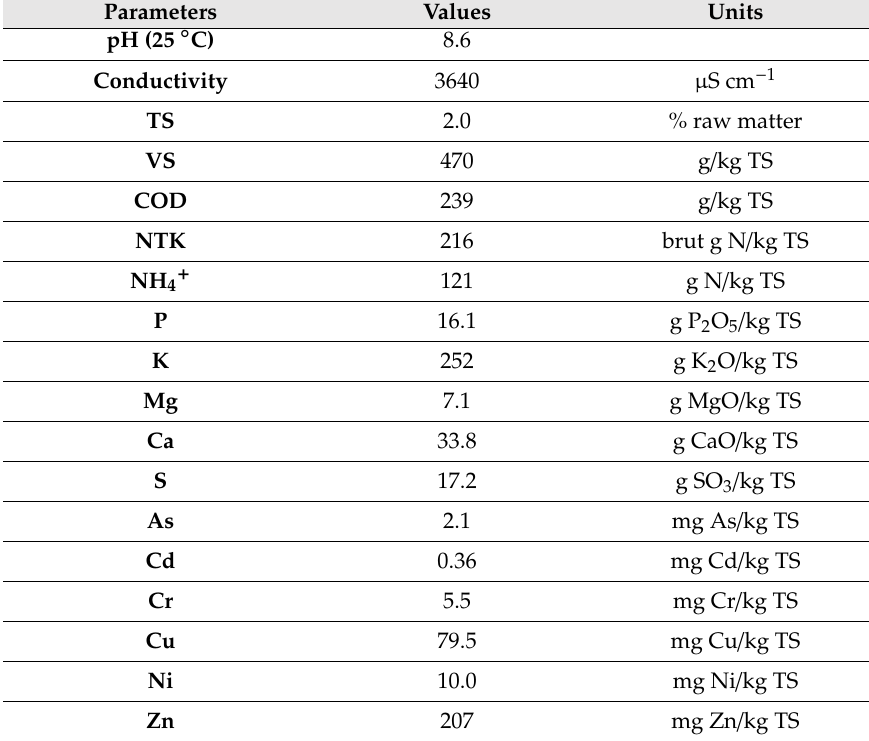
Table 1. Selected chemical properties of the liquid digestate used in this